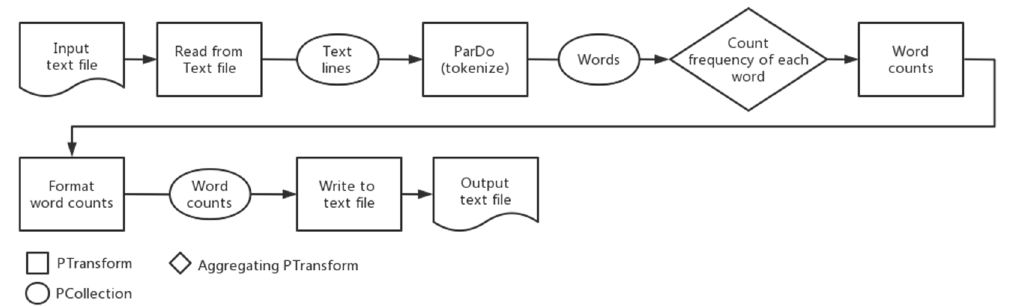
Figure 1. Apache Beam WordCount pipeline data flow.